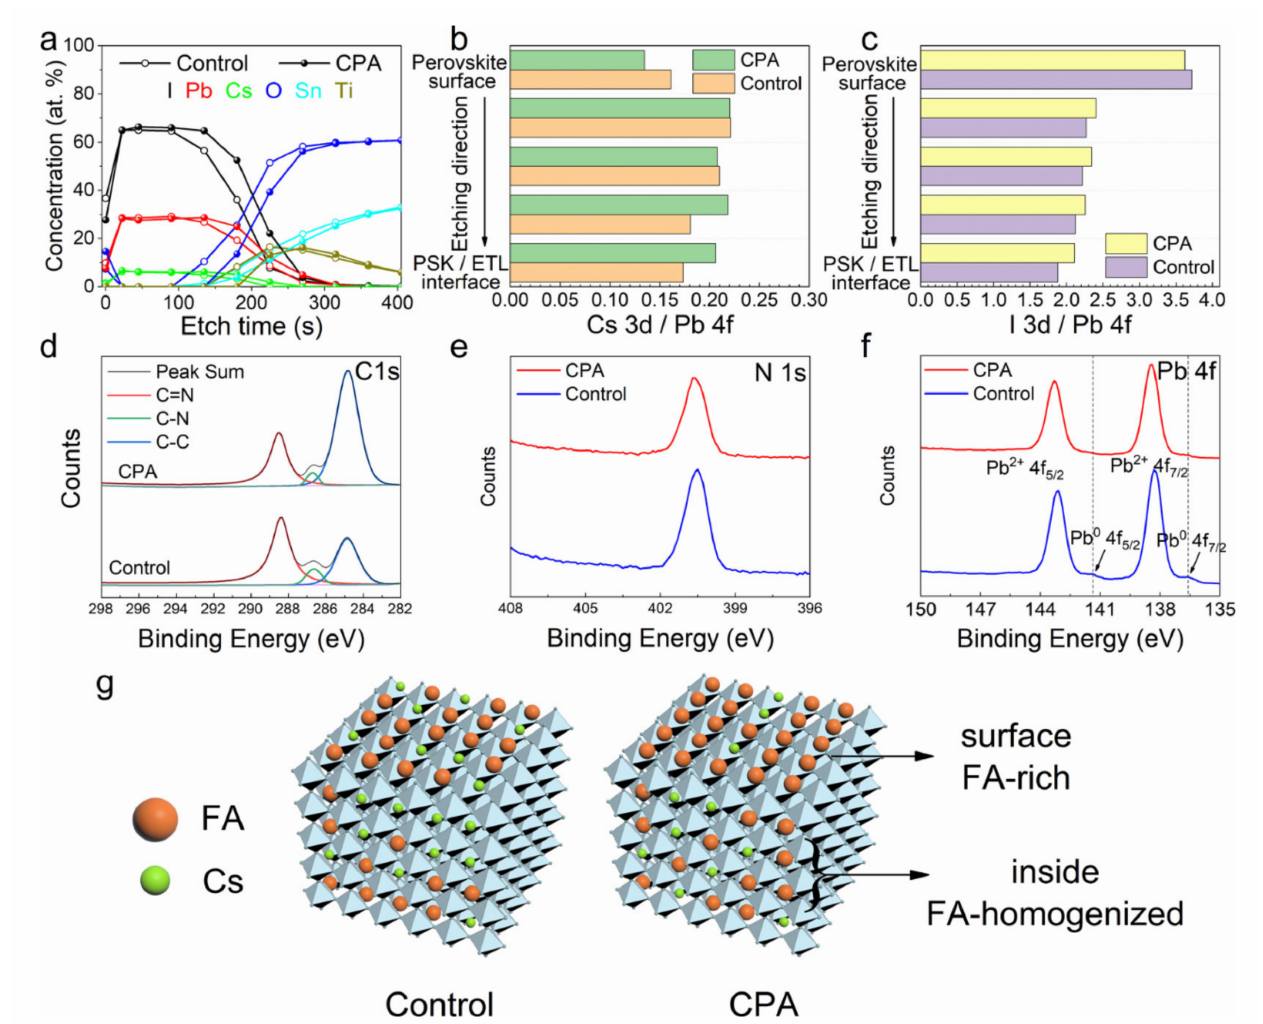
Figure 12. ( a ) XPS depth profiling of the control and CPA half devices with the structure of FTO/TiO 2 /SnO 2 /Cs 0.1 FA 0.9 PbI 3 ; ( b , c ) Evolution of the atomic ratios of Cs 3d/Pb 4f and I 3d/Pb 4f with different etching depths; ( d – f ) XPS spectra of C 1s, N 1s, Pb 4f in control and CPA annealing modes; ( g ) schematic of the surface molecular structure of control and CPA perovskite films and the distribution of A-site atoms. Reprinted with permission from Ref. [125]. Copyright 2020 American Chemical